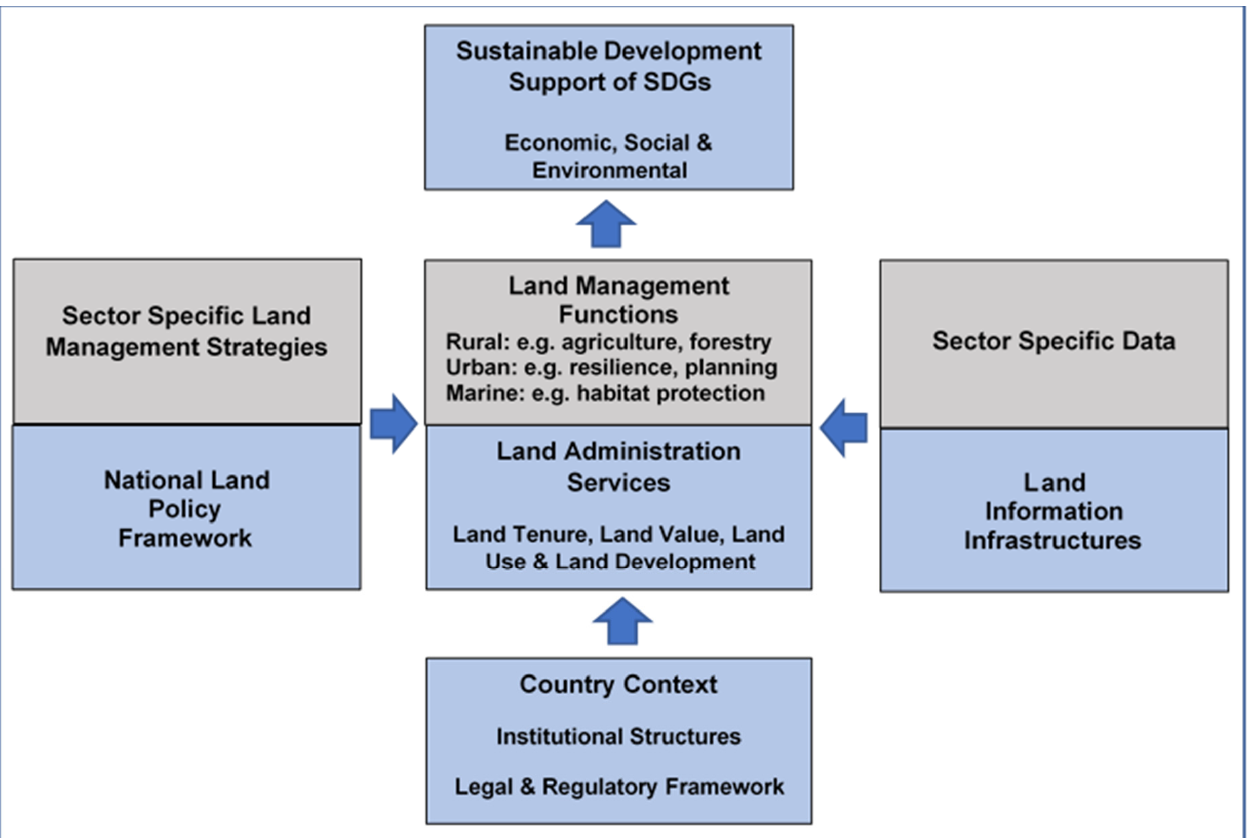
Figure 1. Land Governance Ecosystem (Adapted from The Land Management Paradigm in blue [28] (p.171)).